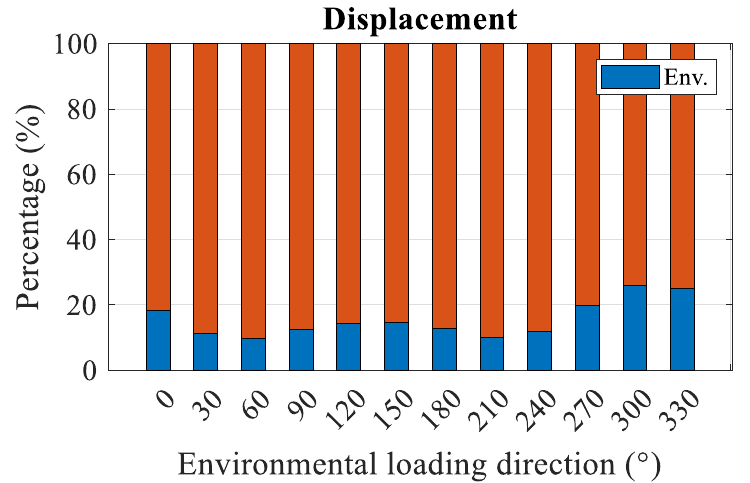
Figure 12. Percentage contribution of Env loads (lateral displacement).